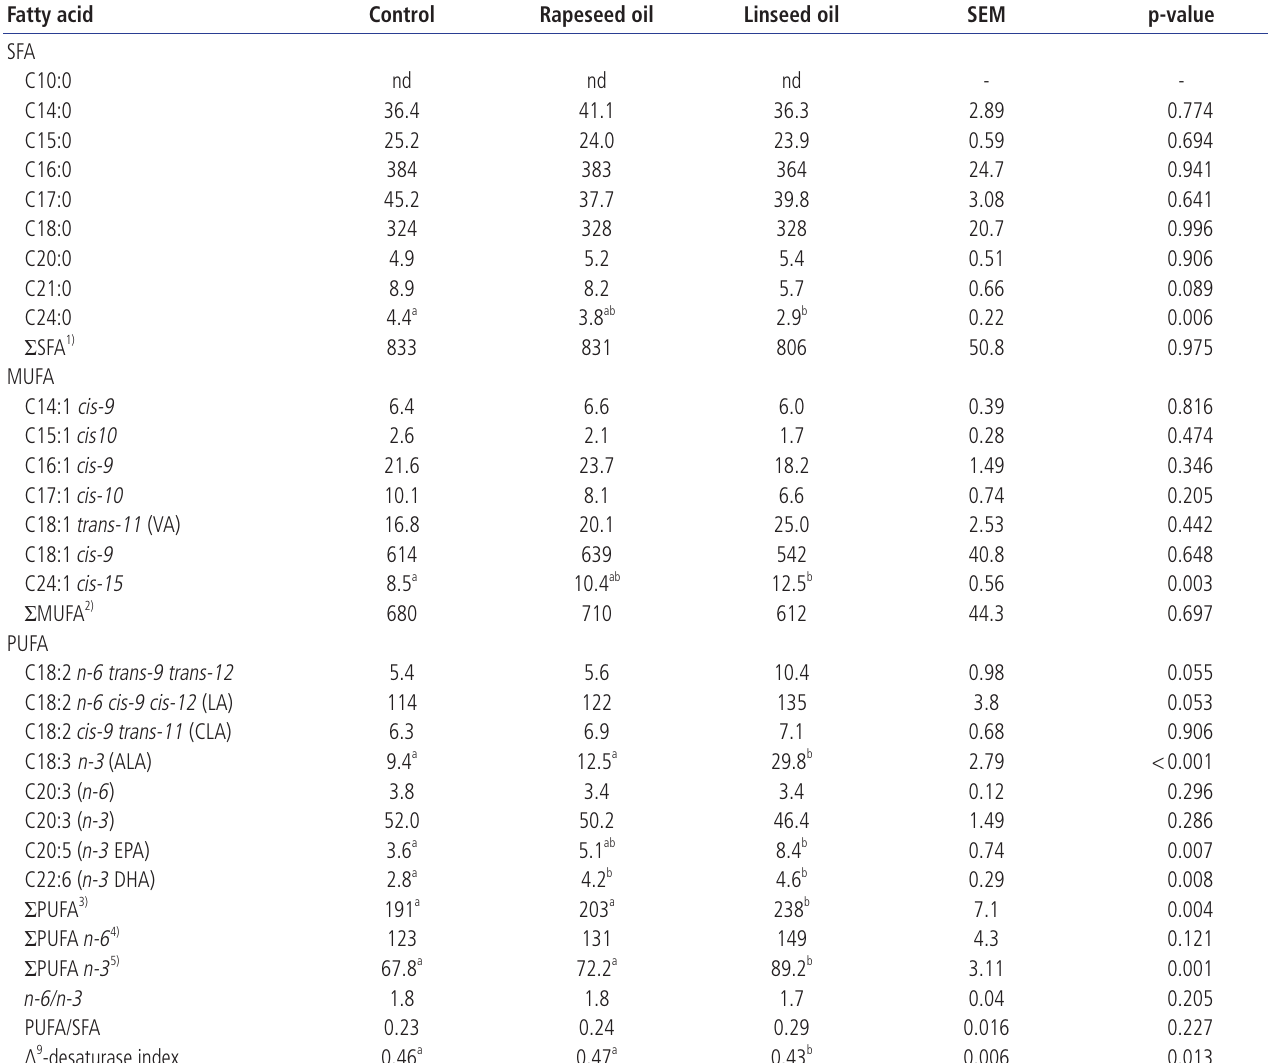
Table 6. The fatty acid composition of semitendinosus muscle in lambs (mg FAME/100 g muscle) Fatty acid Control Rapeseed oil Linseed